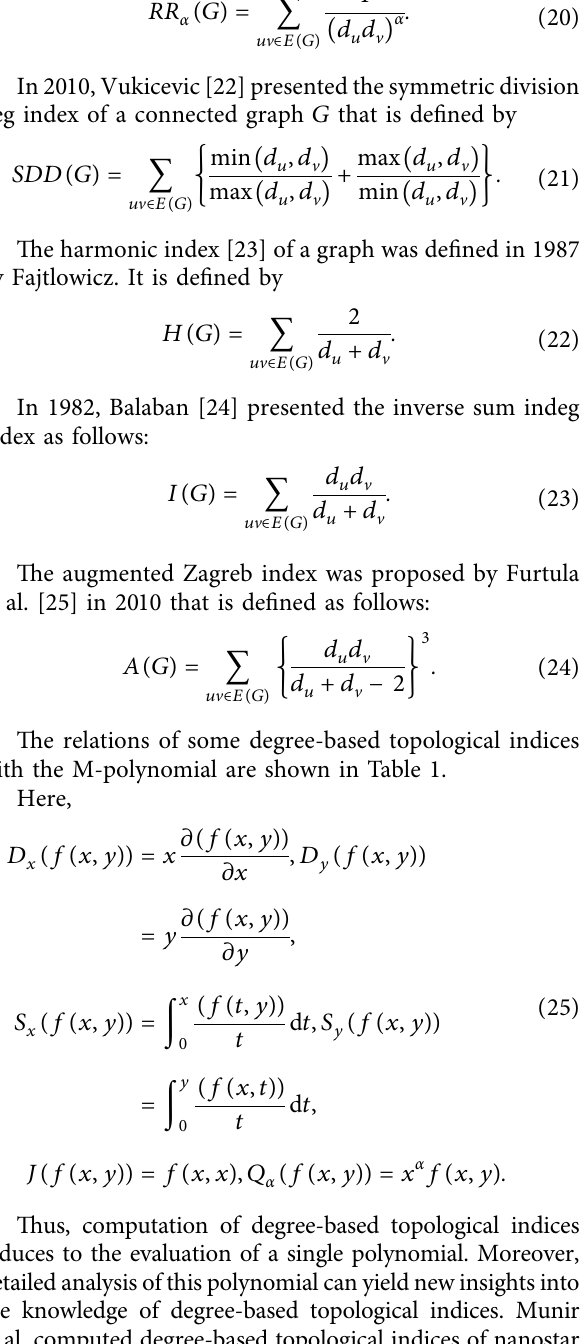
Table 1: Derivation of some degree-based topological